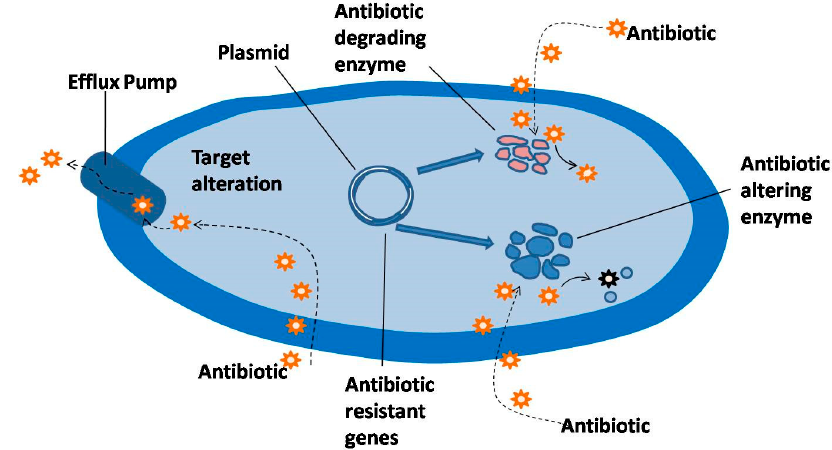
Figure 1. Various ways of resisting the action of antibiotics [8] (Reproduced with permission from IOS Press and D.I. Andersson).